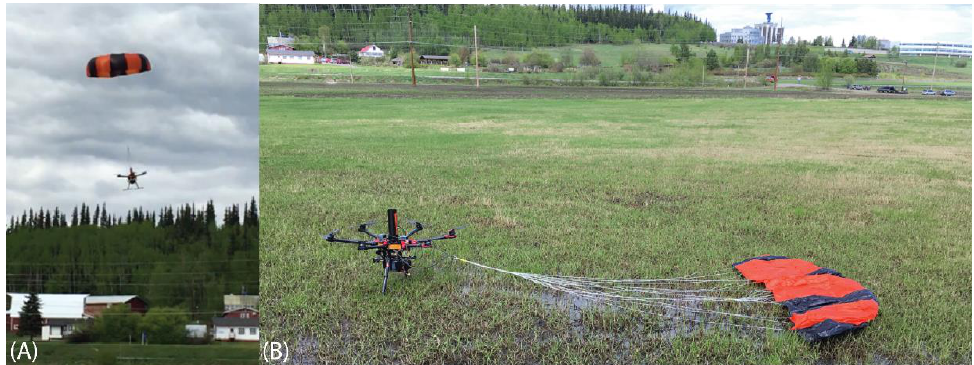
Figure 15. ( A ) S900 hexacopter under canopy and ( B ) S900 after landing.